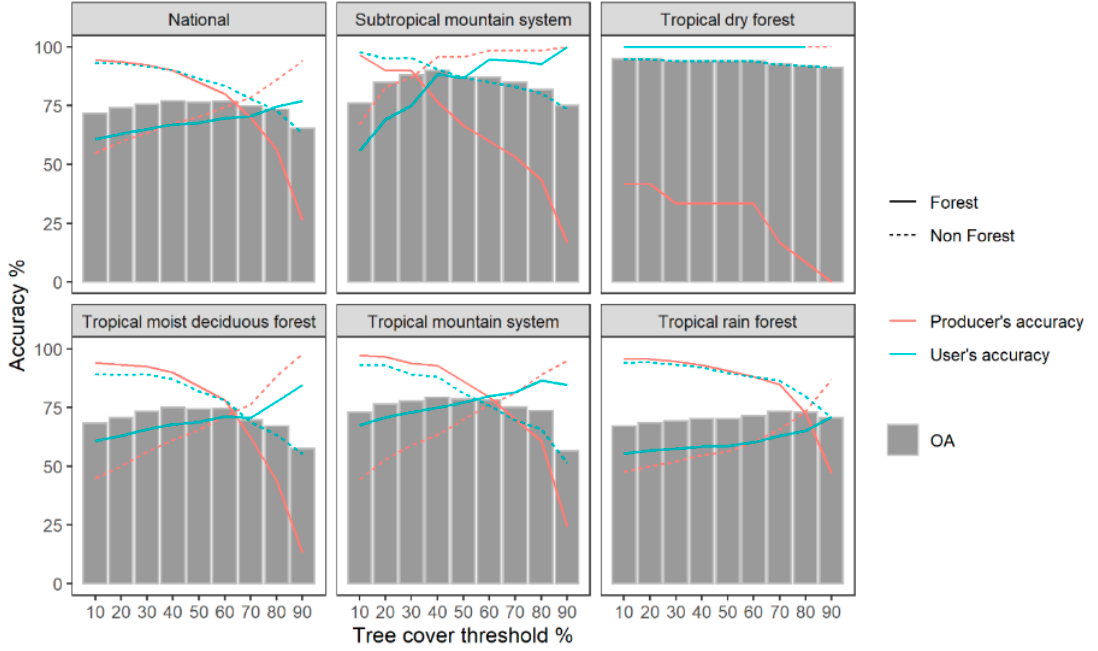
Figure 5. Overall accuracy (OA), producer’s accuracy, and user’s accuracy for forest and non-forest areas at the national scale and in the five ecological zones using the average tree cover percent of nine neighboring pixels.